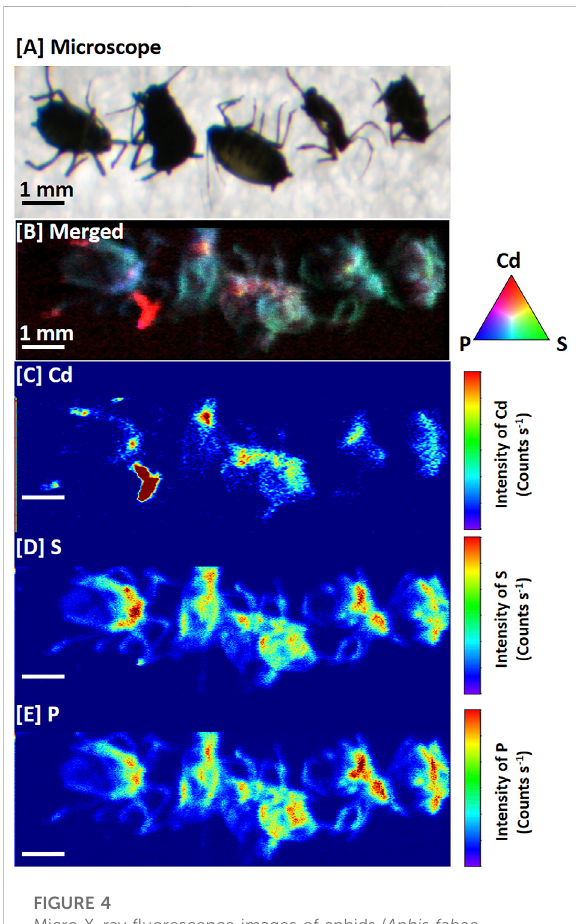
FIGURE 4 Micro X-ray fl uorescence images of aphids ( Aphis fabae Scopoli). Four-week-old Sedum alfredii seedlings were pretreated with 100 μ mol · dm ⁻ ³ (+Cd) CdCl 2 for 7 days in a small and closed environment. Adult aphids were then introduced into the plants, which were further treated with Cd for another 7 days. (A) Photograph ofthetypicalaphids. (B) Color merge imagesshowing the relative locations of cadmium (Cd; red), phosphorus (P; blue), and sulfur (S; green) in the typical aphids. (C) Cd images in the aphids. (D) S images in the aphids. (E) P images in the